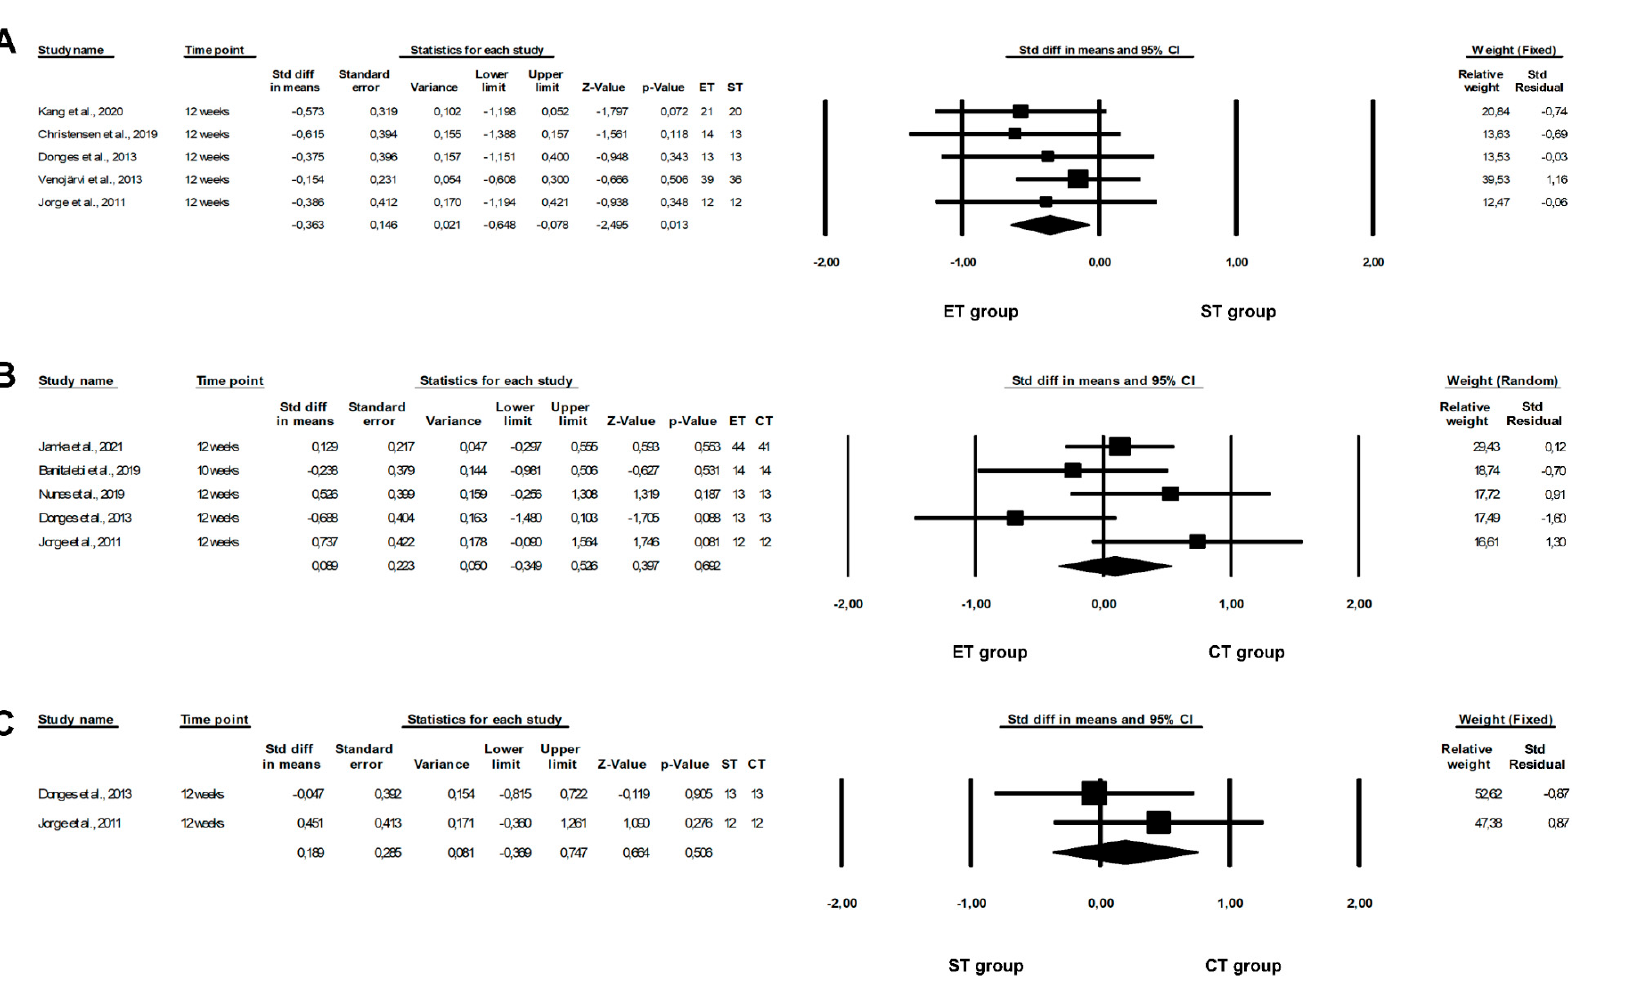
Figure 3. Forest plots of the effect of different training programmes on IL-6 levels: ( A ) ET vs. ST—fixed model; ( B ) ET vs. CT—random model; ( C ) ST vs. CT—fixed model. CI—confidence interval; CT—combined training; ET—endurance training; ST—strength training; Std diff—standard differences [16,21,23– 25,40,46,47].